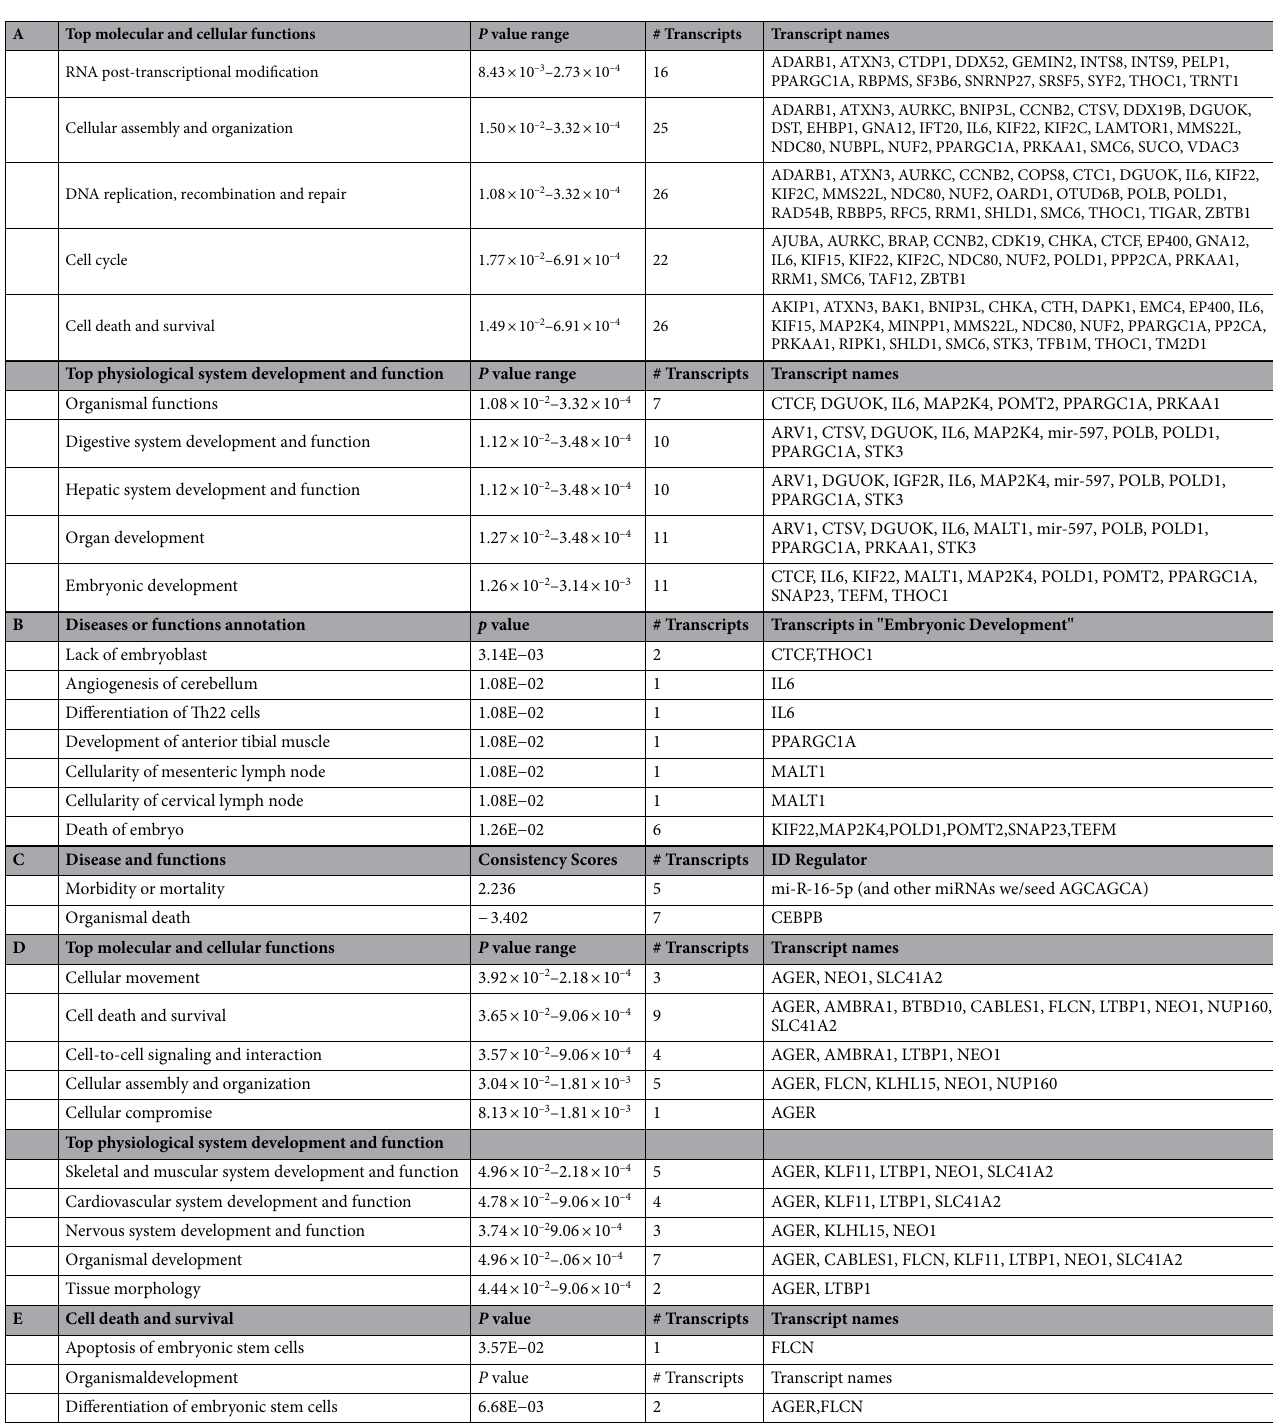
Table 4. Functional annotation of differentially expressed genes by Ingenuity Pathway Analysis (IPA). To investigate possible interactions of the differentially expressed RNAs, the datasets including the 663 upregulated RNAs (A, B, and C) and the 44 downregulated RNAs (D and E) in blastocysts cultured in biphasic (5%-2%)